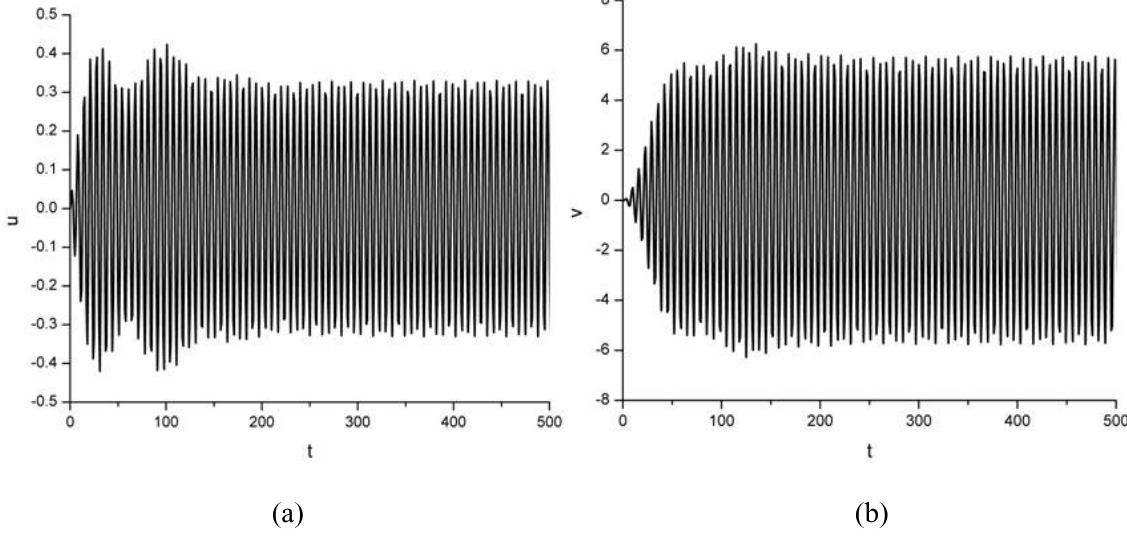
Fig. 21. Numerical simulation of the time response of (a) the plant and (b) the absorber when ω 2 = 0 . 97 , Ω = 0 . 95 and G = 0 . 01